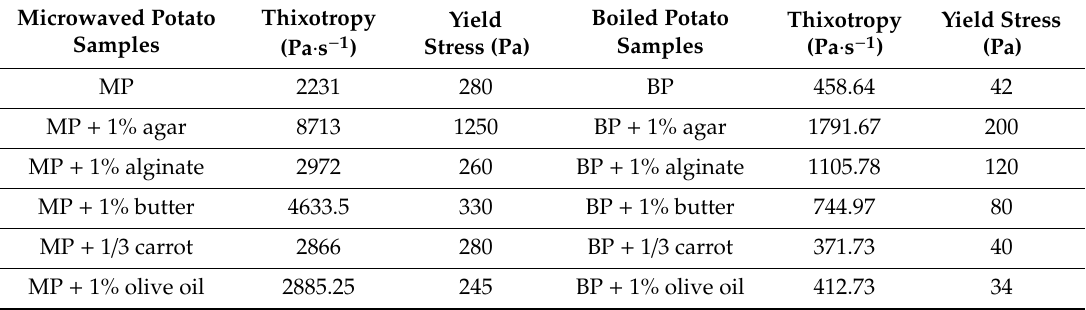
Table 2. Values of thixotropy and yield stress of potato tubers with different types of food additives and after being applied to two methods of cooking microwaving (MP) and boiling (BP).